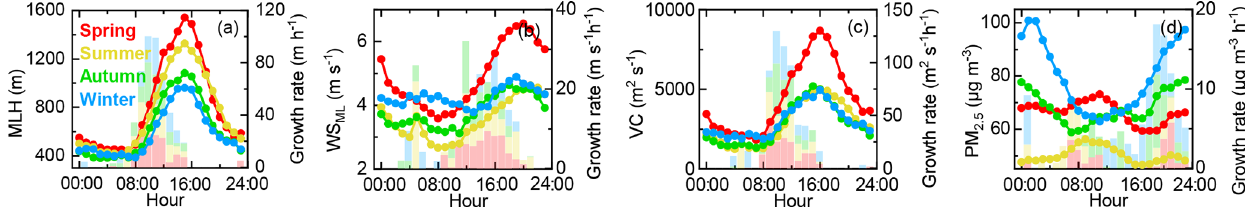
Figure 3. Diurnal variations and growth rates of MLH (a) , WS ML (b) , VC (c) and PM 2 . 5 (d) in the spring, summer, autumn and winter in Beijing. Diurnal variations are represented by lines and scatters. Growth rates are represented by columns, and only positive values are shown in the figure.